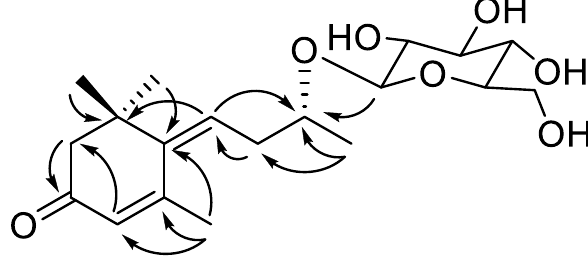
Figure 2. Key HMBC correlations (from H to C) for compound 1 .